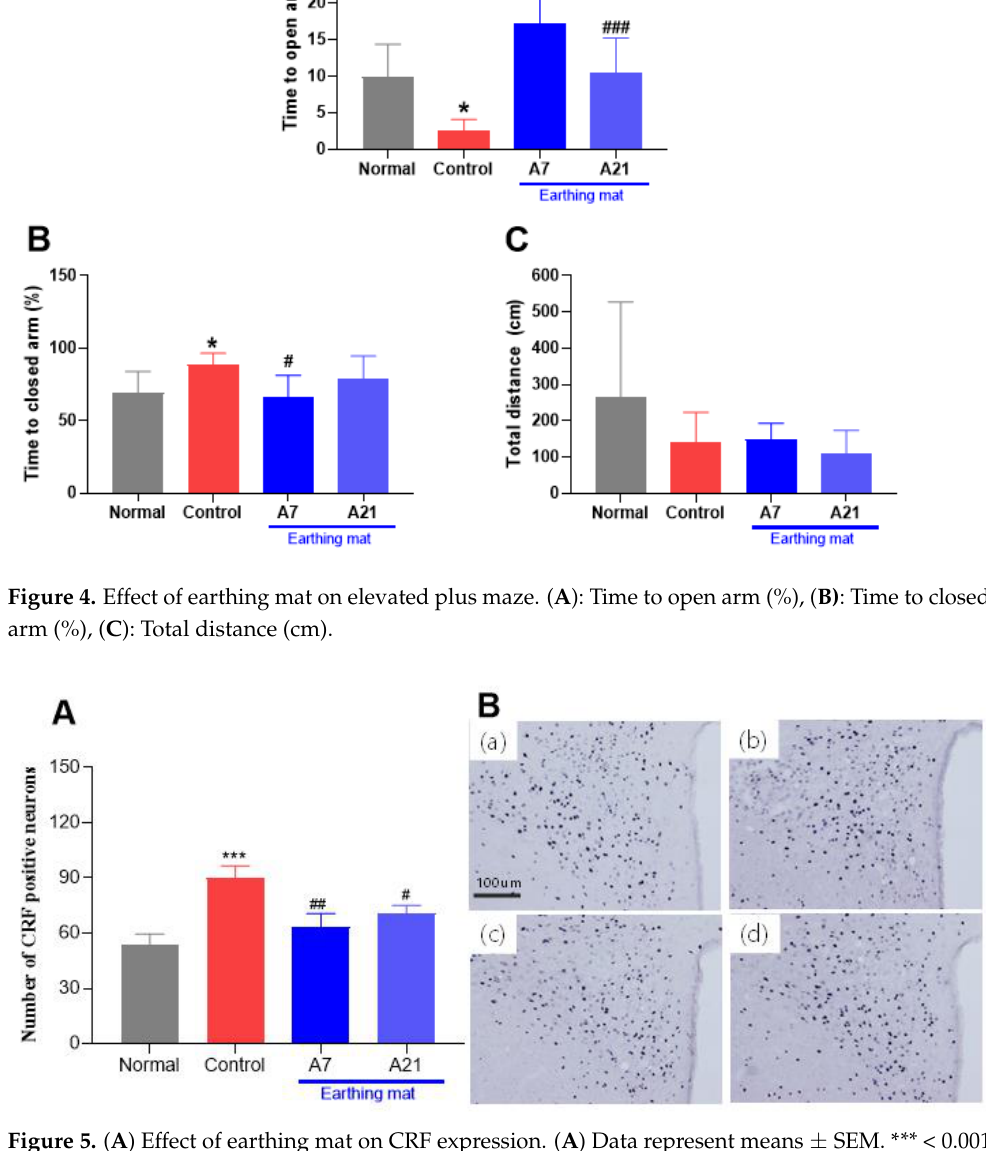
Figure 5. ( A ) Effect of earthing mat on CRF expression. ( A ) Data represent means ± SEM. * ** < 0.001 compared to Normal group, # p < 0.05, ## p < 0.01 compared to Control group. ( B ) Photographs showing the distribution of CRF immunoreactive cells in the PVN of the ( a ) Normal group, ( b ) Control group, ( c ) A7 group, ( d ) A21 group. Coronal sections were 30 µ m thick, and the scale bar represents 100 µ m.